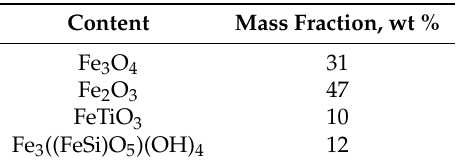
Table 5. XRD analysis of the solid residue with 0.42 mol/L concentration of ammonium fluoride solution and hydrofluoric acid with concentration of 4.07 mol/L.